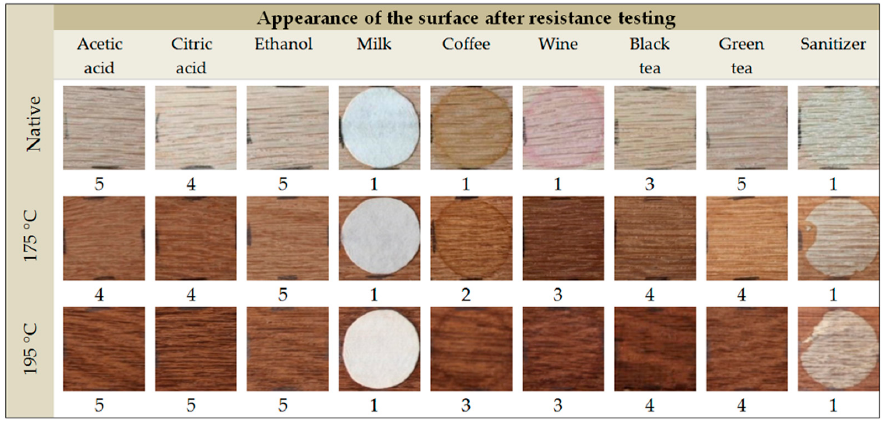
Coatings 2021 , 11 , x FOR PEER REVIEW 15 of 19 Figure 9. Resistance to cold liquids (degree): wax surface finish. Figure 9. Resistance to cold liquids (degree): wax surface finish.